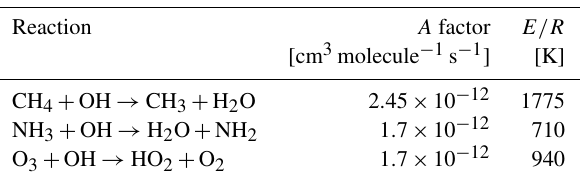
Table 2. Bimolecular reaction rate coefficients for the hydroxyl rad- ical. See Burkholder et al. (2019) for